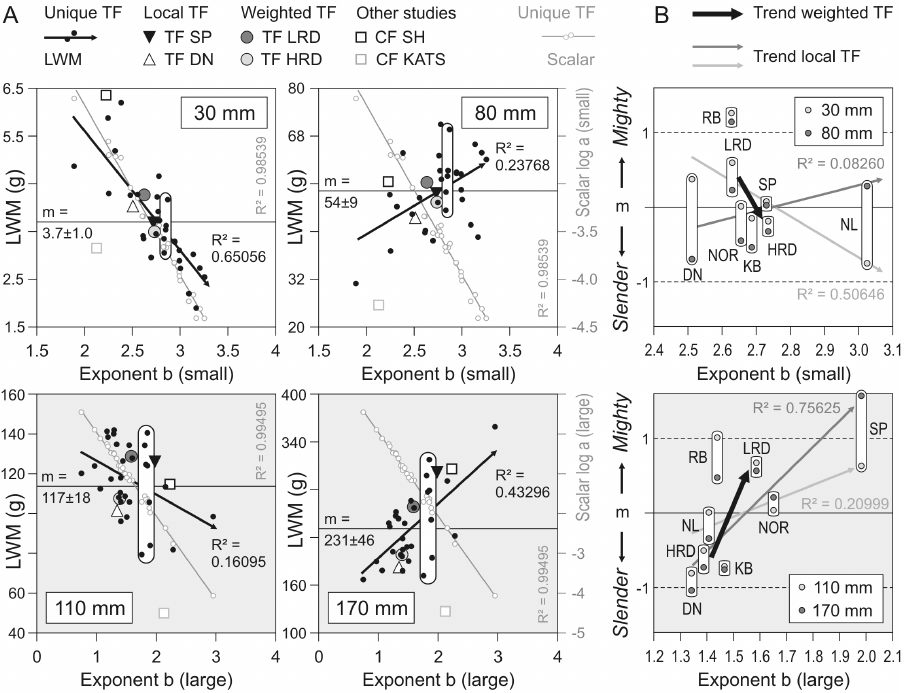
Figure 6. Relationship between scaling exponent and oyster LWM (g) of selected small (SL 30/80 mm, top) and large (SL 110/170 mm, bottom) individuals. A Plotted is LWM resulting from unique TF, se- lected local TF (SP for mighty and DN for slender shaped oysters), weighted TF (LRD, HRD) and CF of two other studies (SH, KATS) against exponent, respectively. Mean LWM (horizontal line, m ± SD) and linear trend of increasing or decreasing LWM with increasing exponent of unique TF indicated (black ar- row, R²). Variability of LWM resulting from similar exponents of unique TF highlighted (rounded boxes). Additionally plotted is the exponential relationship (broken line, R² upend) between scalar and exponent of unique TF (gray circles). B Plotted is relative shape resulting from local TF (SP, RB, NOR, NL, KB, DN) and weighted TF against exponent. Relative shape = (LWM-m)/SD with 0 = m and 1 = SD. Change of oyster shape with increasing exponent is displayed as a linear trend between sites (gray arrows, R²). Trend between reef types indicated (black arrow). R² = coefficient of